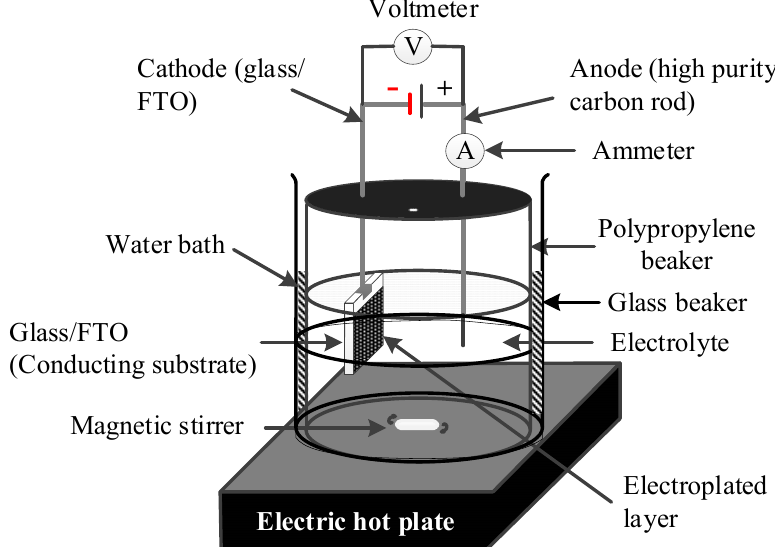
Figure 1. Typical two-electrode electrodeposition configuration.